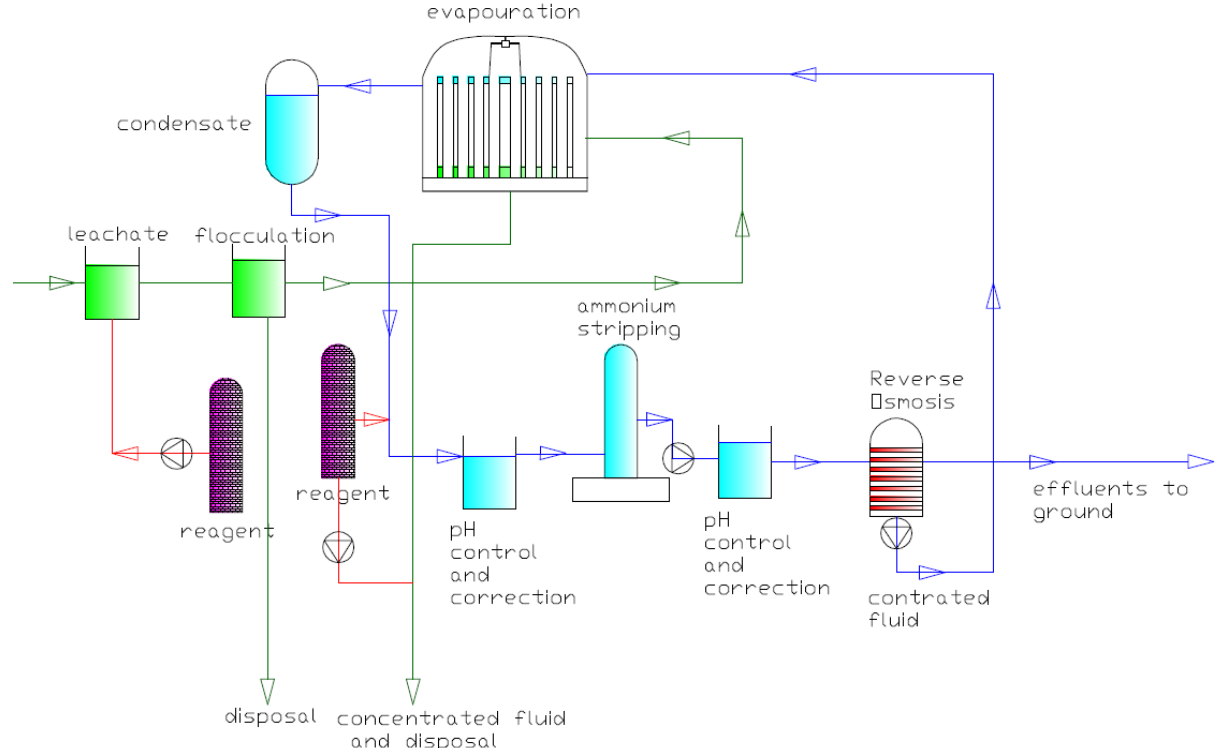
Figure 1. Unifilar diagram of the treatment plant in Scenario